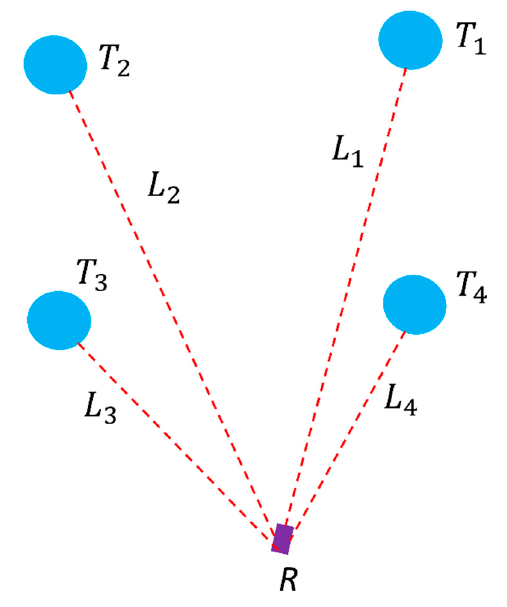
Figure 6. The multilateration operation diagram, where T 1 , T 2 , T 3 , T 4 , and R are the LED transmitter– receiver, respectively, and L 1 , L 2 , L 3 , and L 4 are the calculated distances between transmitters and receiver.